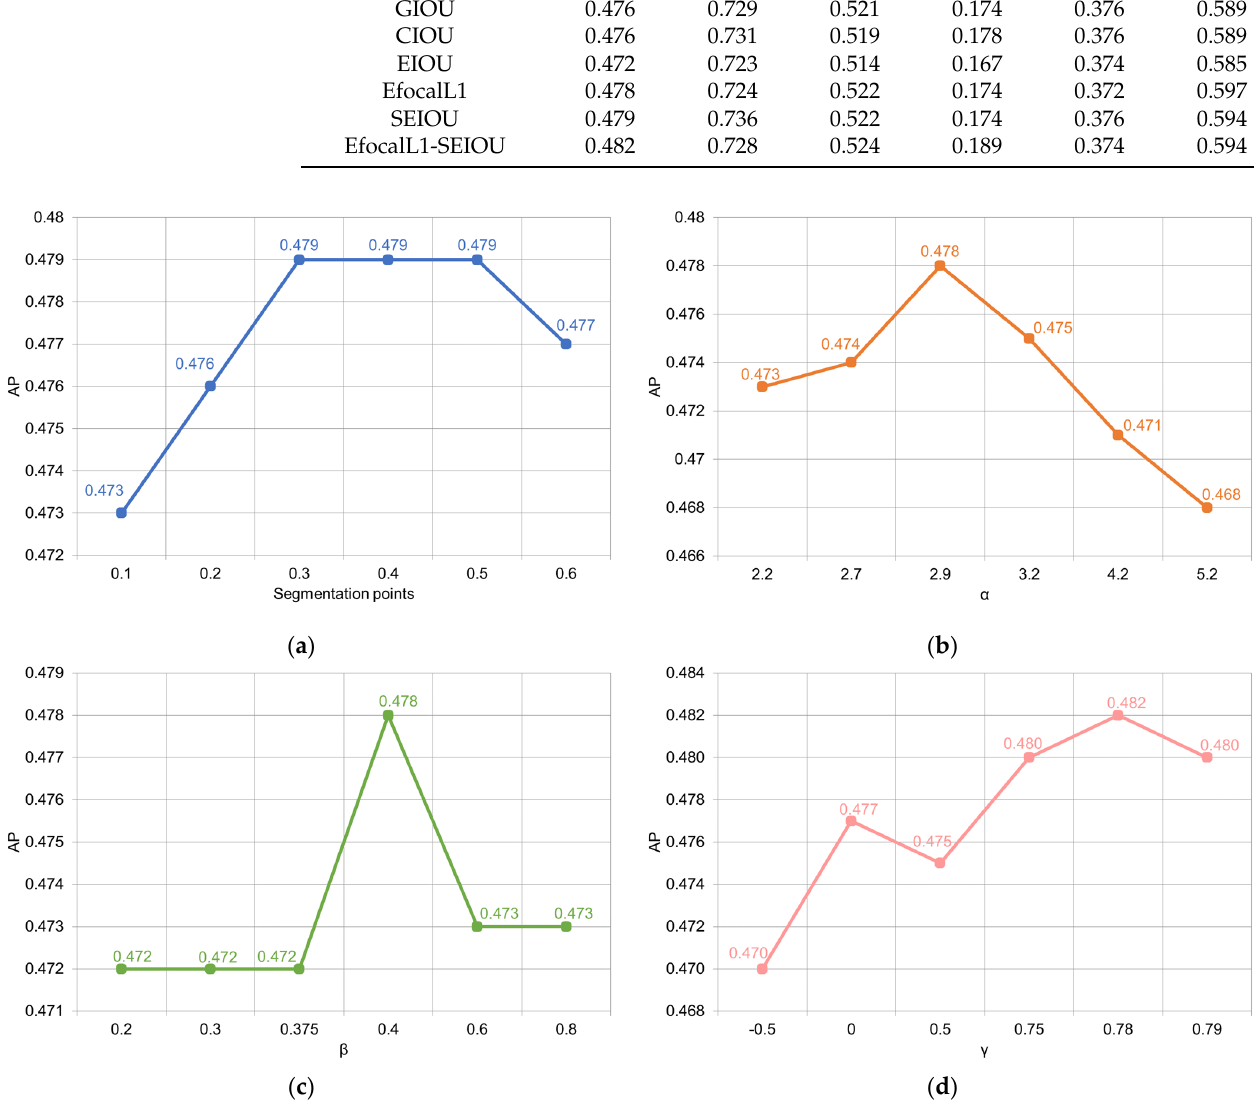
Figure 7. Performance of methods with different value of parameters. ( a ) SEIOU loss with different segmentation points; ( b ) EfocalL1 loss with different α ; ( c ) EfocalL1 loss with different β ; ( d ) EfocalL1-SEIOU loss with different γ . Table 1. Overall ablation studies on MOCS.